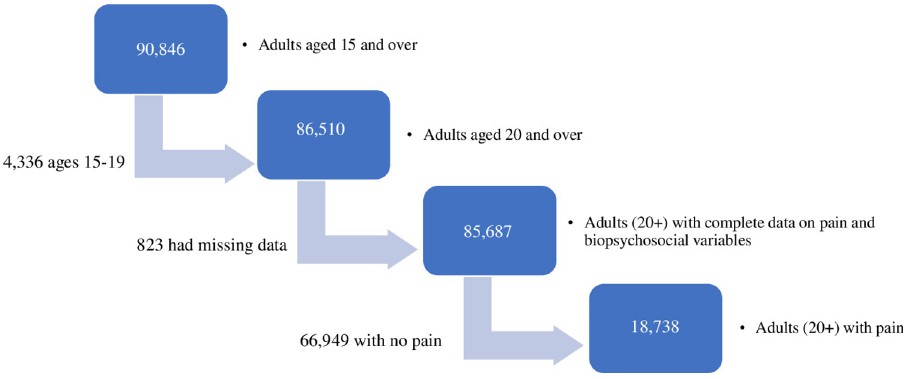
Fig 1. Participants flowchart in the